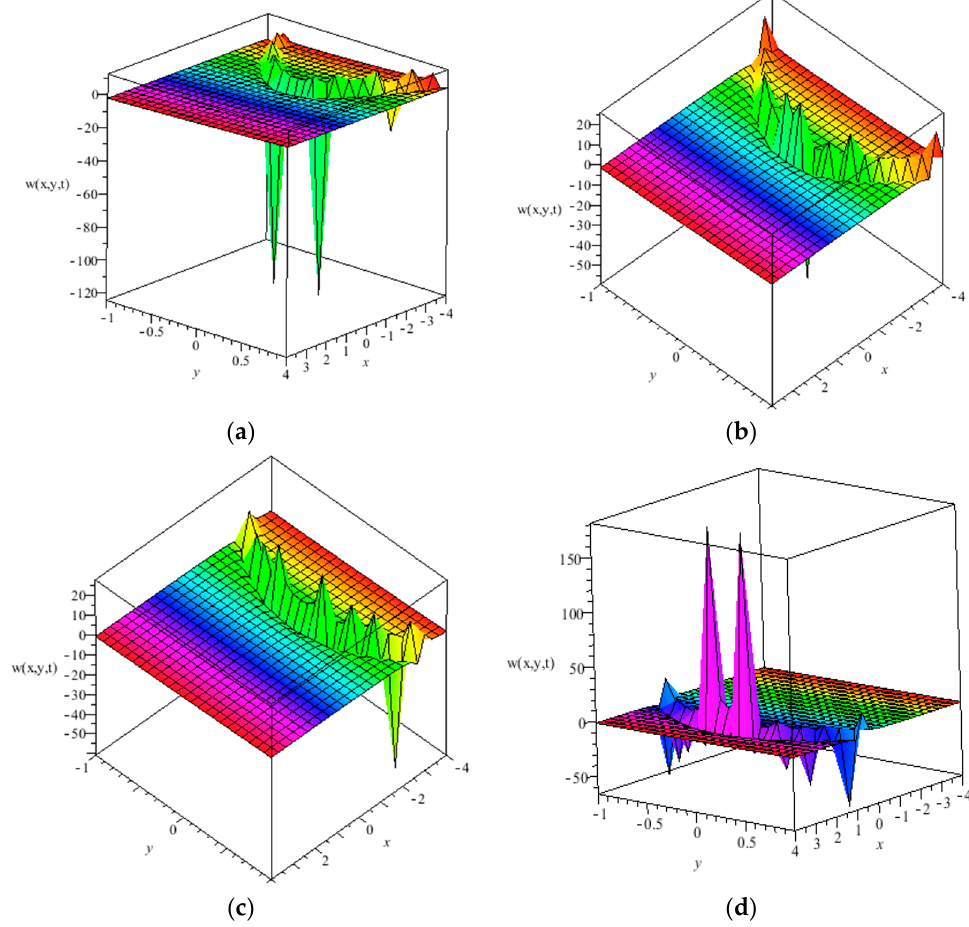
Figure 2. ( a ) w ( x, y, t ) at c = 1, t = 0.3 s; ( b ) w ( x, y, t ) at c = 1, t = 0.5 s; ( c ) w ( x, y, t ) at c = 1, t = 0.8 s; ( d ) w ( x, y, t ) at c = − 2, t = 0.8 s.